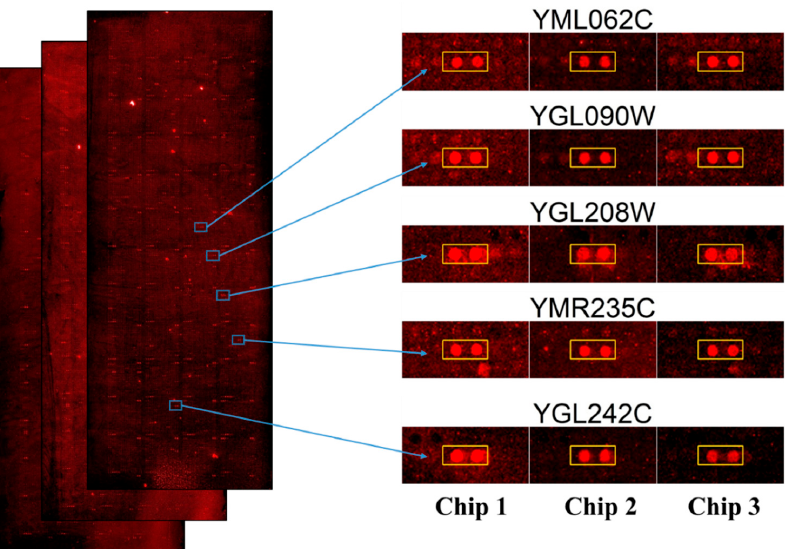
Figure 2. Image of protein targets of penetratin identified from yeast proteome microarrays. Entire yeast proteome microarrays probed with penetratin followed by streptavidin-DyLight 650 ( left ); enlarged images of each representative protein targets (in duplicate red spot enclosed inside the yellow box) of penetratin from the triplicate yeast proteome microarrays ( right ).